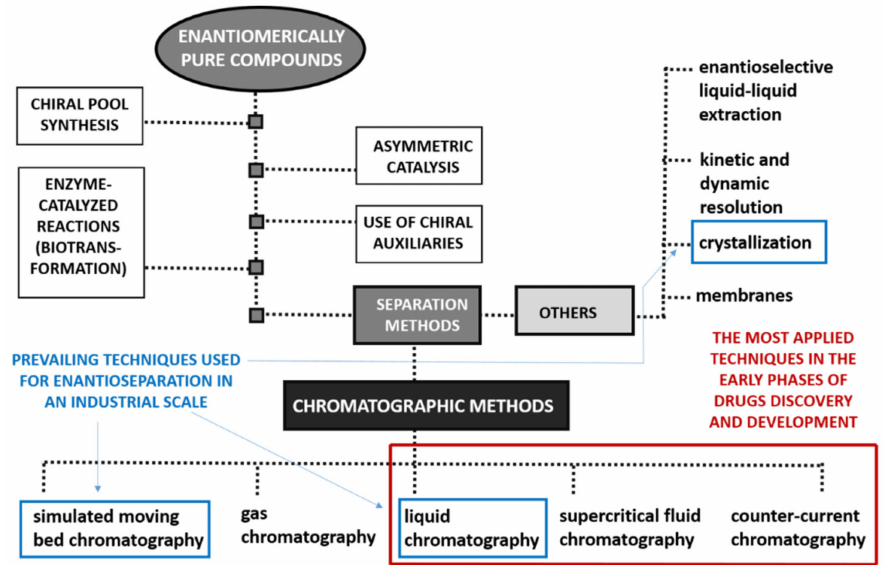
Figure 1. Di ff erent ways to obtain enantiomerically pure